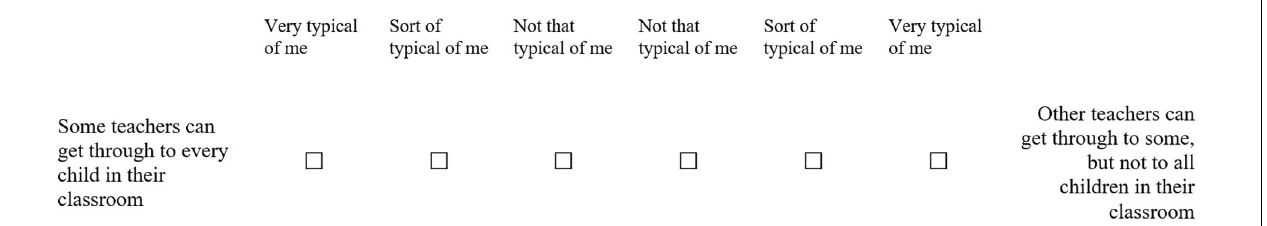
FIGURE 1 | Example item of dyadic relationship-building